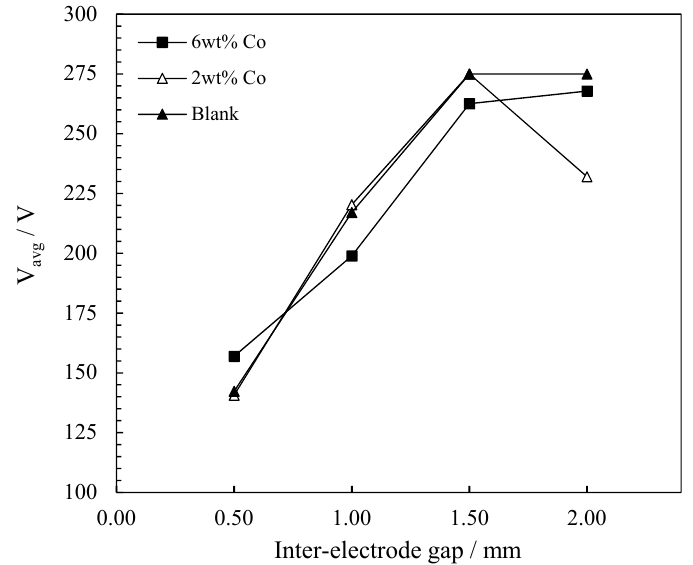
Figure 12. The influence of inter-electrode gap on rms voltage for plasma-catalytic FTS (NTP + Blank, 2 or 6 wt% Co catalyst) at a discharge time of 60 s. Legend: ■ —6 wt% Co; Δ —2 wt% Co; ▲ —Blank. Operating conditions: Syngas (H 2 /CO) ratio: 2.2:1; pressure: 2 MPa; current: 350 mA; wall temperature: 25 °C.